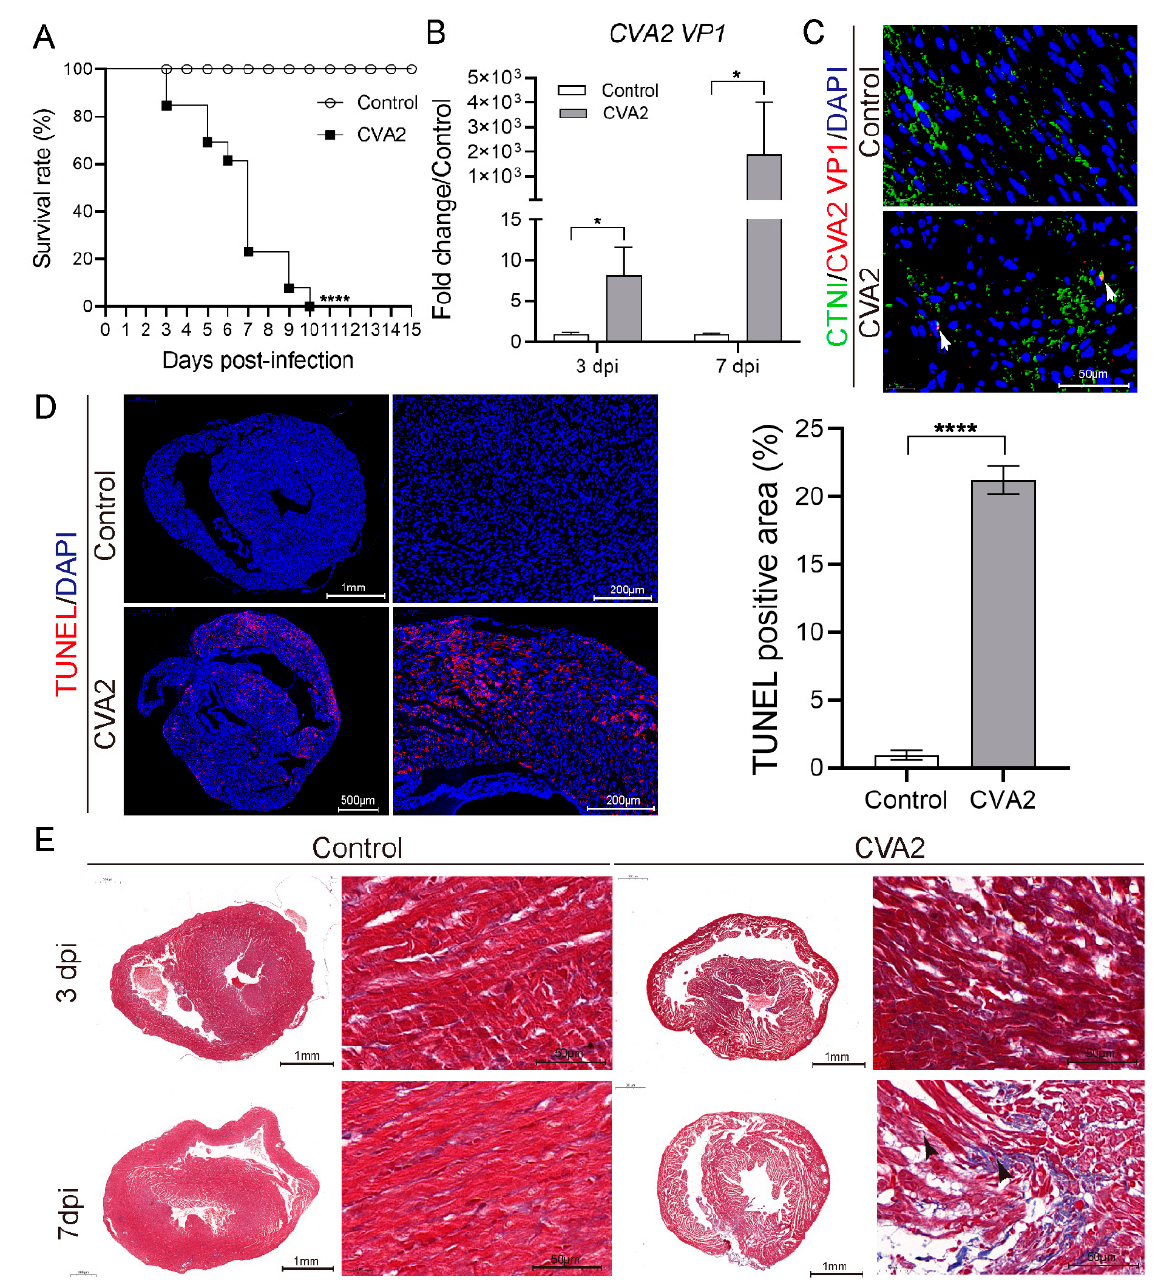
Figure 1. CVA2 infection leads to heart injury in a neonatal mouse model. ( A ) The survival rates of mice in two groups. ( B ) The transcription level of VP1 mRNA at 3 dpi and 7 dpi ( n = 4 per group). ( C ) Colocation of VP1 protein (red) and CTNI (green) in heart slices and white arrows indicate infected cardiomyocytes ( n = 4 per group). ( D ) Cardiomyocyte apoptosis was evaluated by TUNEL assay in heart slices ( n = 4 per group). ( E ) Masson staining of the heart tissues was performed to evaluate the histological changes at 3 dpi and 7 dpi ( n = 4 per group). The black arrows indicate the damage of cardiomyocytes. * p < 0.05, **** p < 0.0001 vs. control.